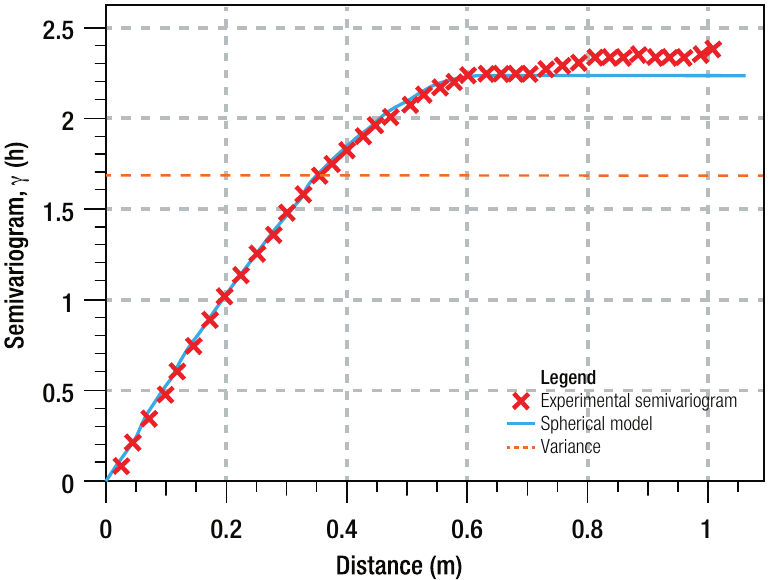
Figure 6. Experimental semivariogram and omnidirectional theoretical model for q d in the vertical direction. Full survey